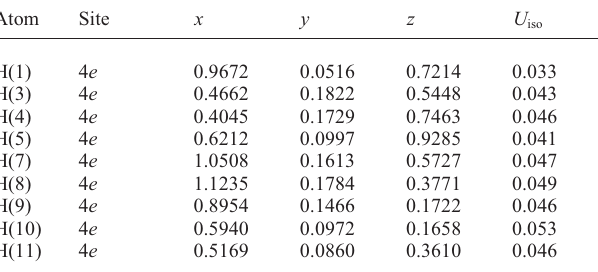
Table 2. Atomic coordinates and displacement parameters (in Å 2 )